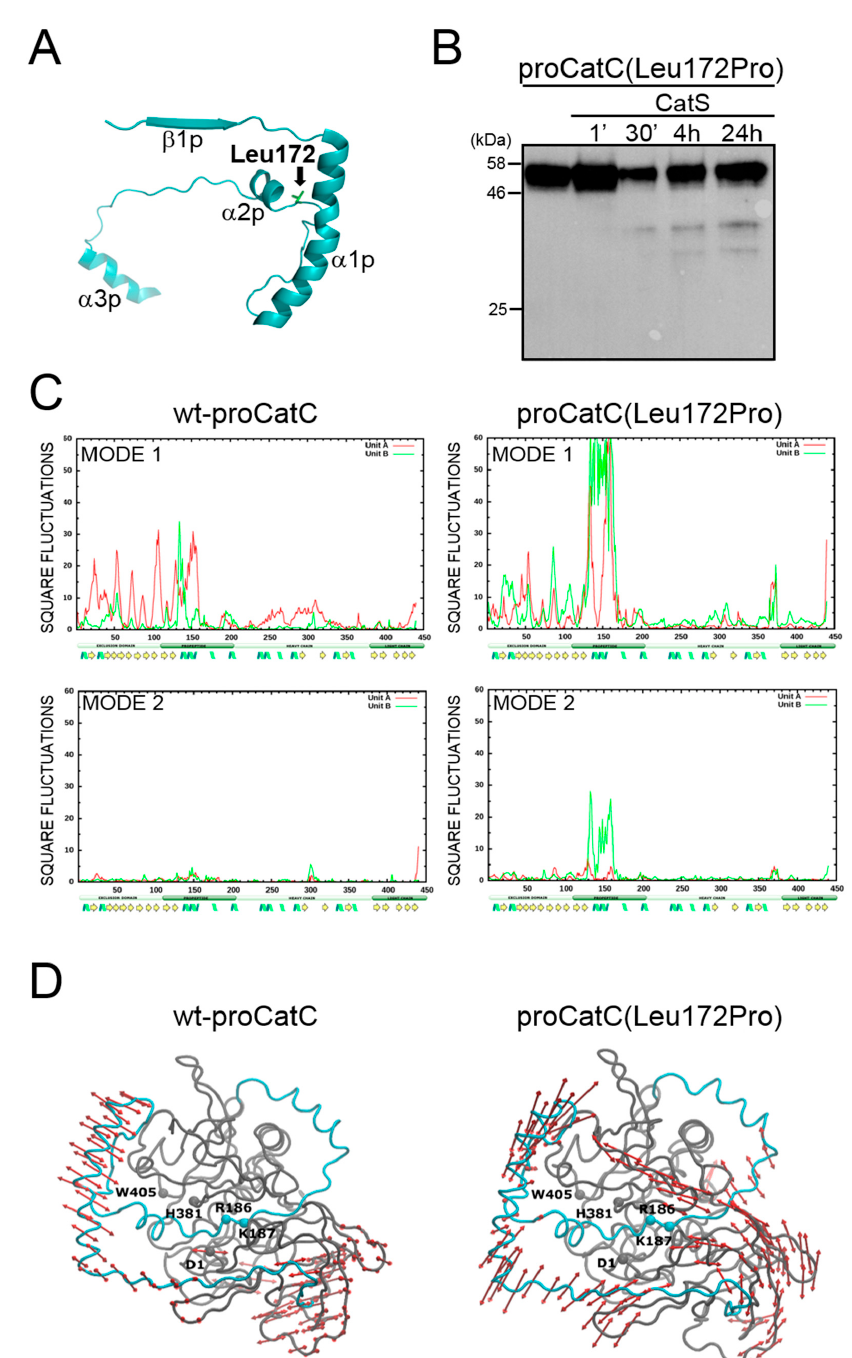
Figure 5. Production, processing and principal component analysis (PCA) of proCatC(Leu172Pro). ( A ) Model structure of proCatC propeptide in ribbon plot, showing the location of Leu172. ( B ) Western blot analysis of proCatC(Leu172Pro) produced in HEK293 cells and incubated with CatS. Purified recombinant proCatC(Leu172Pro) was incubated at 37 °C for different time intervals with human recombinant CatS. Similar results were obtained in three independent experiments. ( C ) PCA analysis of wt-proCatC and ProCatC(Leu172Pro). ( D ) Model structures of wt-proCatC and proCatC(Leu172Pro) monomers. Red: exclusion domain, cyan: propeptide, green: heavy chain, blue: light chain. The arrows are the eigenvectors as calculated by using the first eigenvalue of the covariance